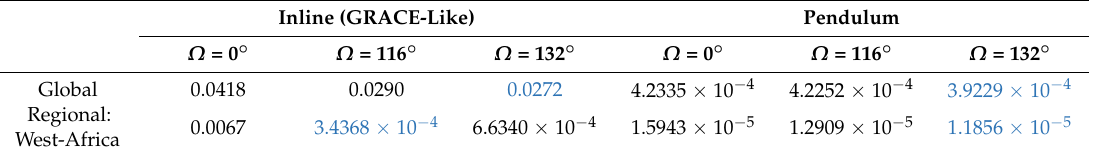
Table 9. Error RMS in terms of geoid height for global and regional (West-Africa) 6-day recovery up to L max = MCNR of the scenario (a) inline and Pendulum formations. The smallest values in global and regional cases for each inline and Pendulum formation are written in